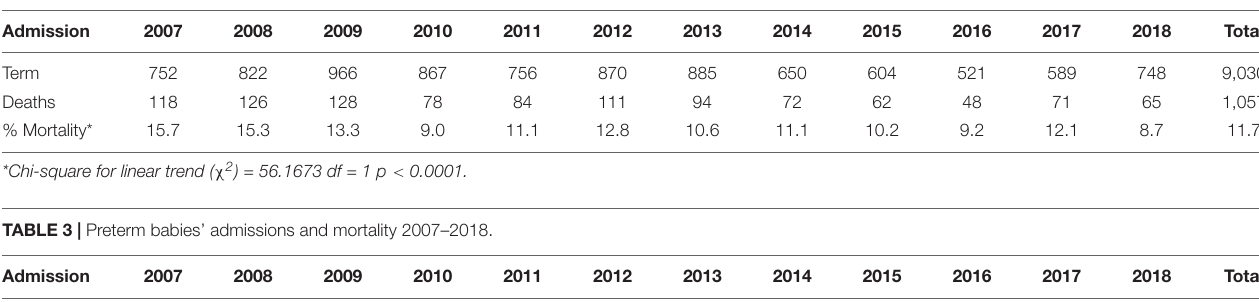
TABLE 2 | Admissions and mortality trends in Term babies 2007–2018.